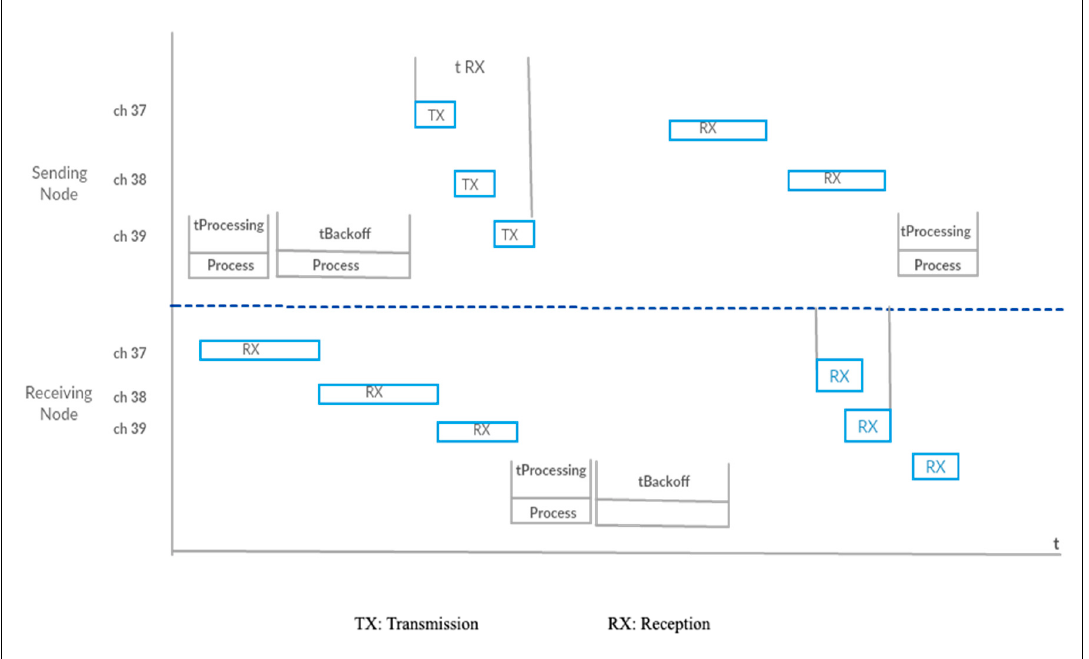
Figure 8. Communication in Bluetooth mesh [11].